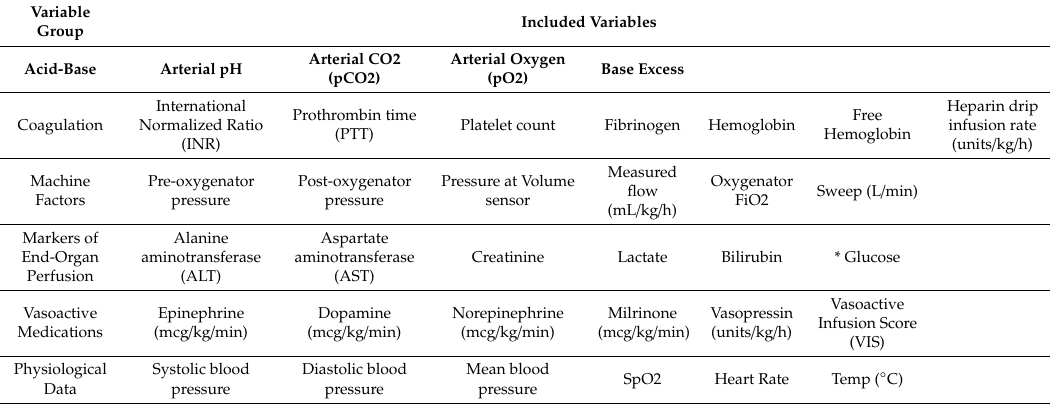
Table A1. Breakdown of which variables were included within each group.